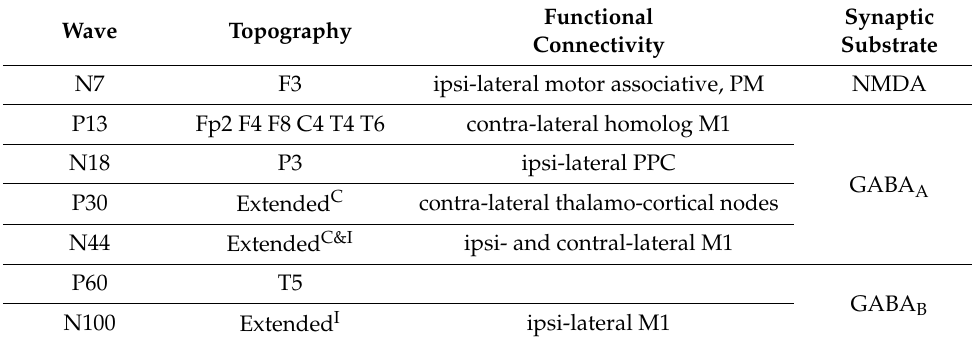
Table 1. M1-TMS TEP components. Wave